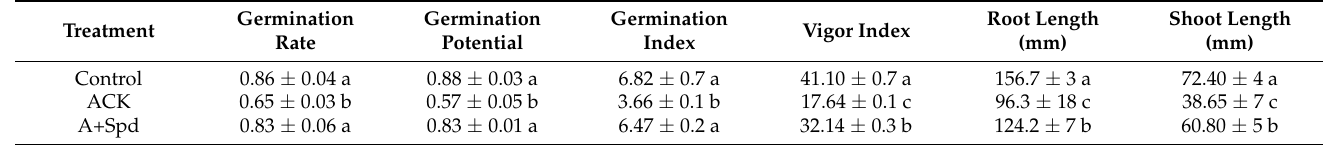
Table 1. Exogenous Spd improves germination traits of aged sorghum seeds.